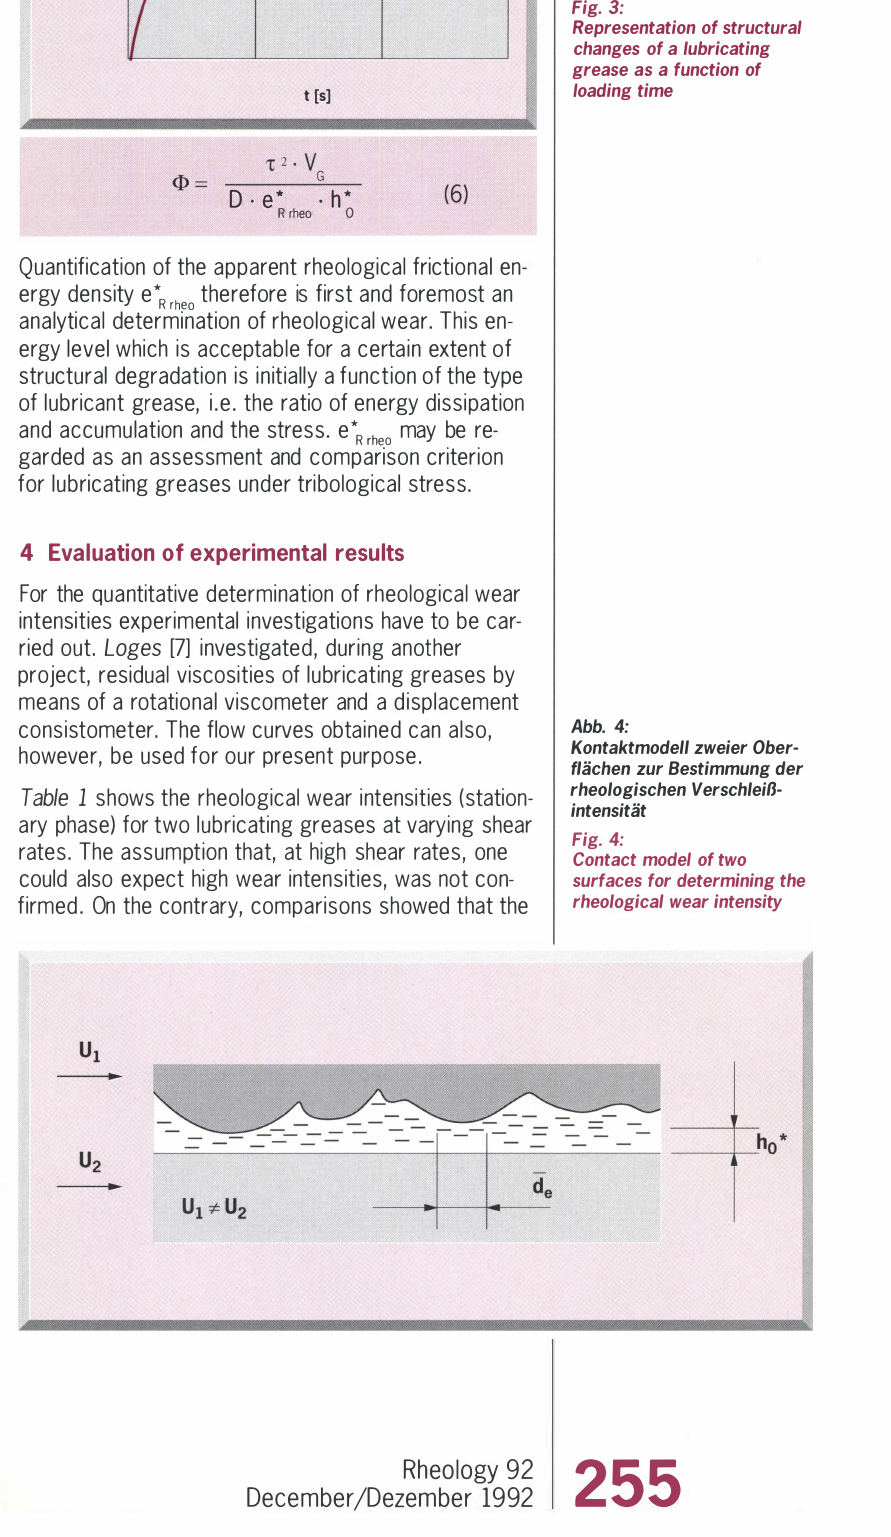
Fig. 3: Representation of structural changes of a lubricating grease as a function of loading time